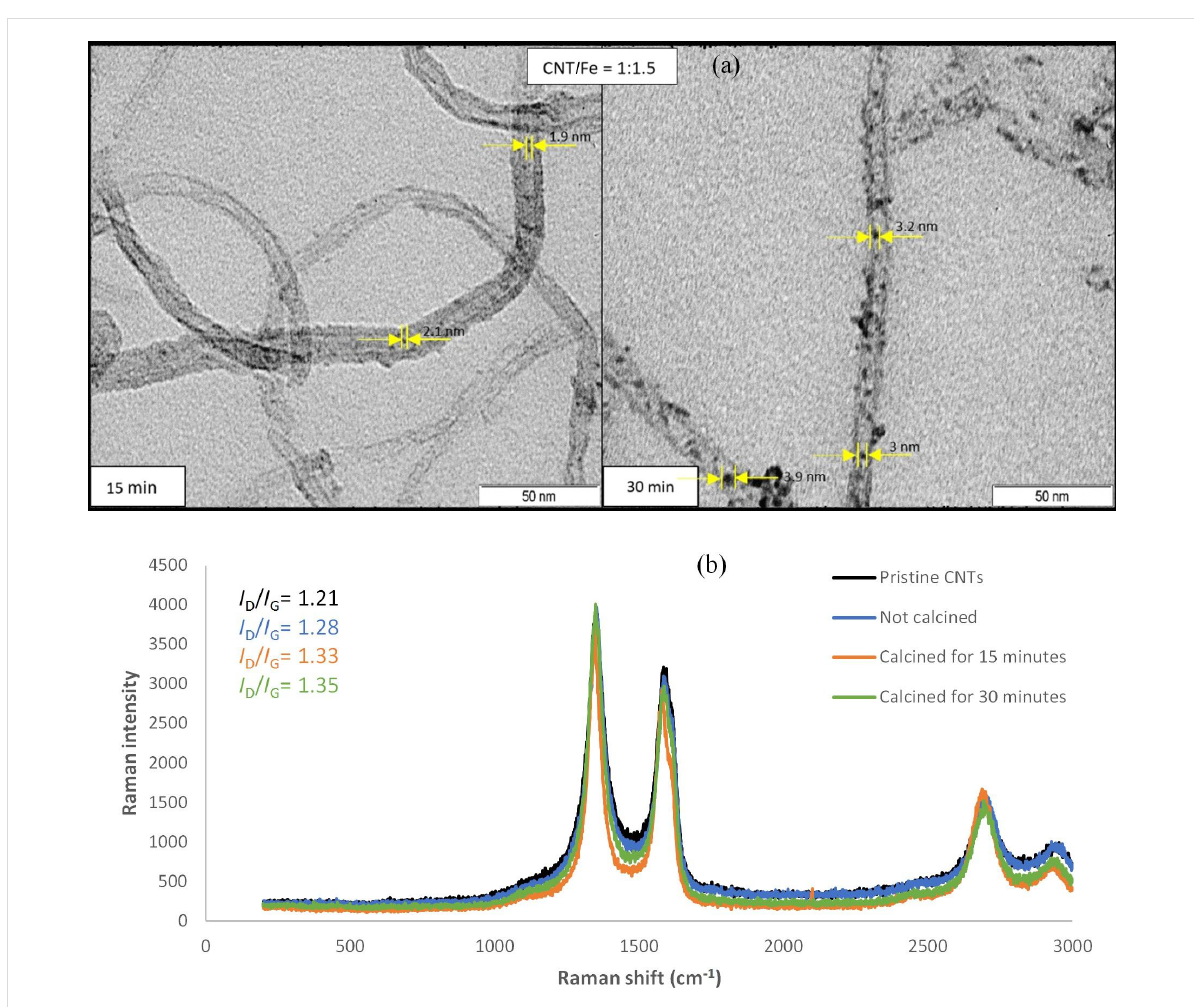
Figure 9: TEM images showing nanocluster size (a) after calcination for 15 minutes and 30 minutes for a 1:1.5 decoration ratio and Raman spectra for pristine CNTs and decorated CNTs with different calcination periods for (1:1.5) decorated COOH–CNTs (b).